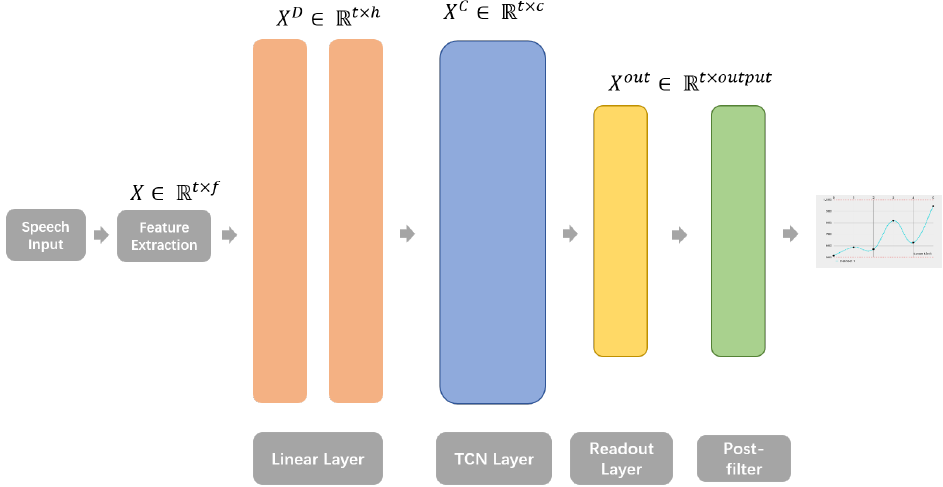
Figure 3. The visualization of the TCN-based AAI